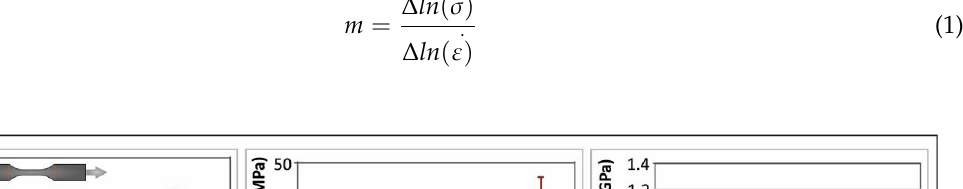
Figure 1. An overview diagram demonstrating the whole process followed to manufacture and test the five different polymeric samples.